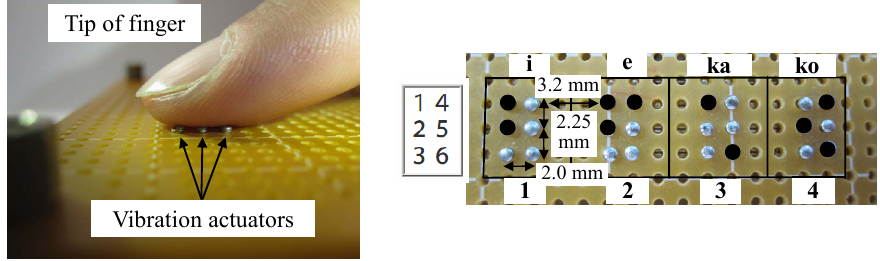
Fig.6 Braille Display with 4